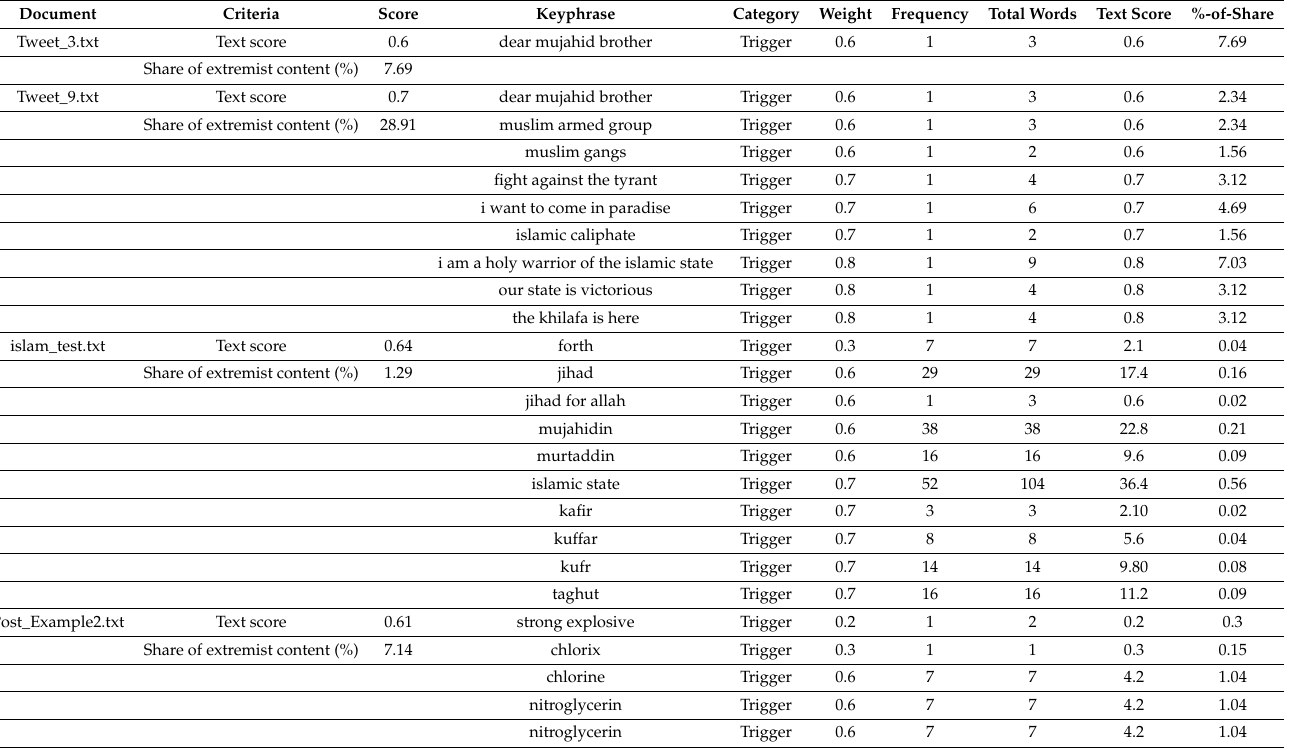
Table 3. Text score is explained by the individual terms that occur in the text—weighted lexicon case. The same texts as in Table 1 are presented.